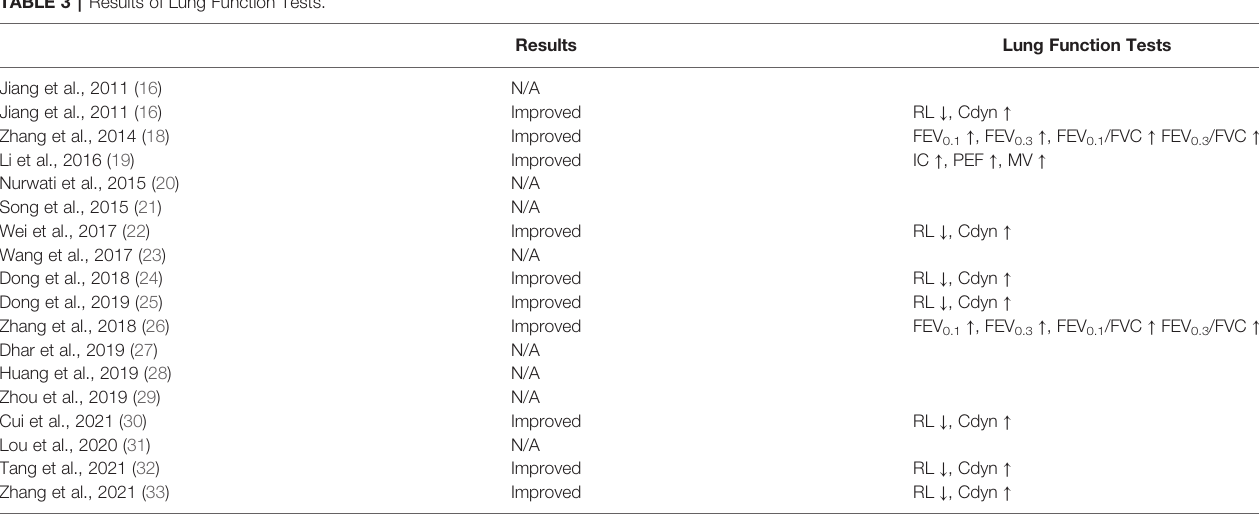
TABLE 3 | Results of Lung Function